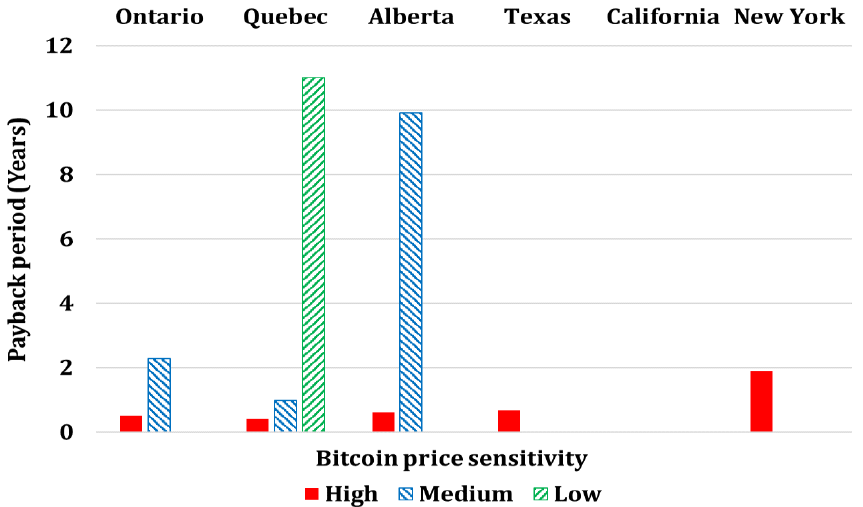
Figure 24. Payback period results from the initial investment for a commercial MightyPOD container operating in six North American locations measured in years.